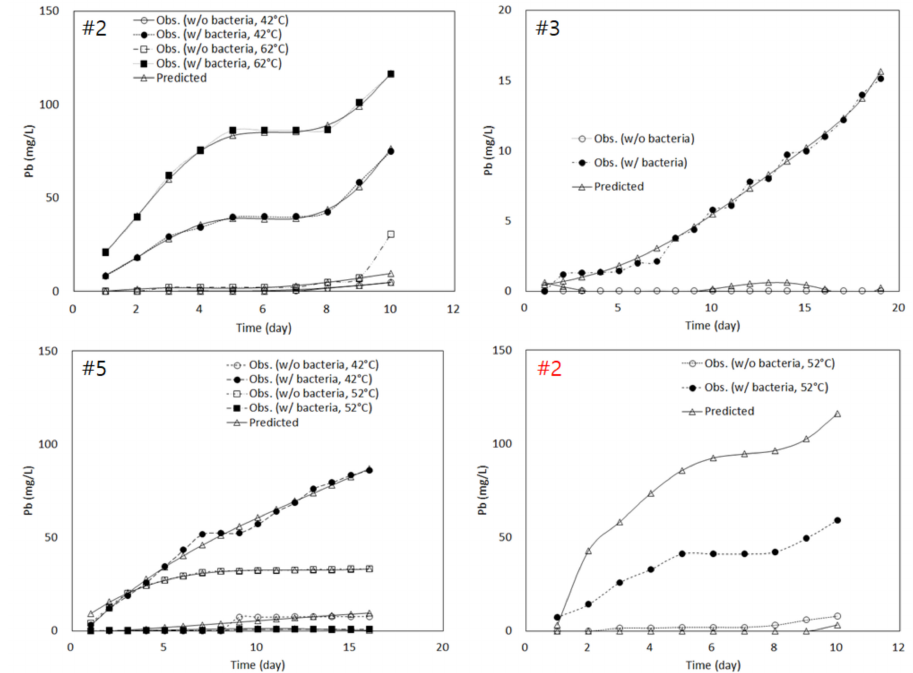
Figure 6. Observed and ANN-predicted Pb concentration changes with a topology of 9:8:1. The numbers are from Table 1, while the red number is the result from the data for further verification.